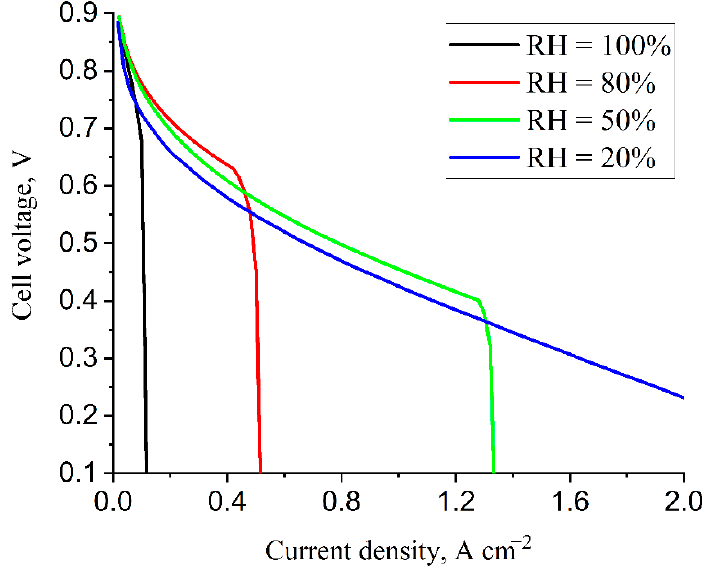
Figure 6. Performance of the model PEMFC at various values of relative humidity of inlet gases (hydrogen/oxygen).